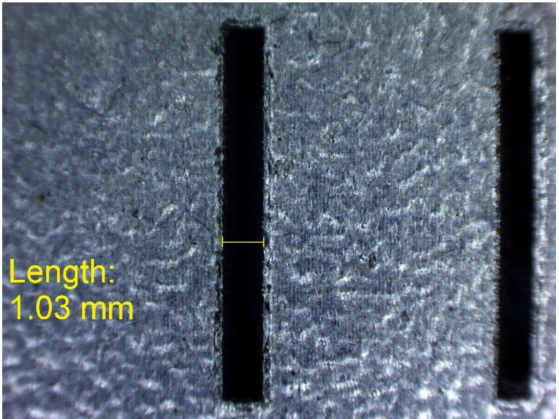
Figure 17. Measurement result for cuboidal holes and solids made in the DMLS technology: cuboidal hole with a nominal width of 1 mm (L m1 = 1.03